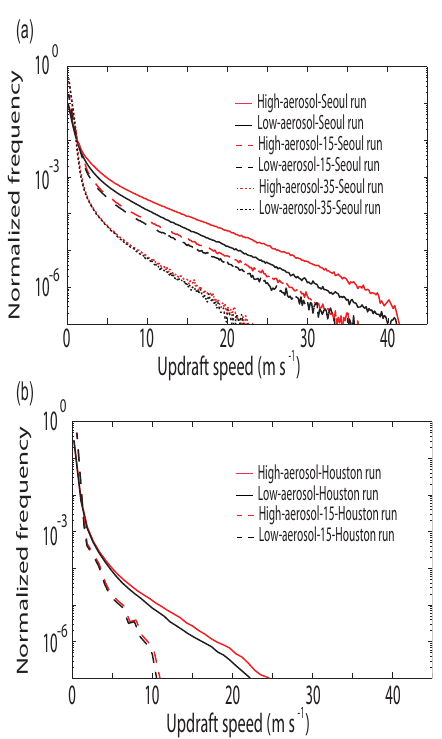
Figure 10. Distributions of normalized updraft frequency over up- draft speeds for (a) the Seoul case and (b) the Houston case. Solid lines represent simulations at the 500m resolution, while dashed lines represent those at the 15km resolution. Dotted lines represent simulations at the 35km